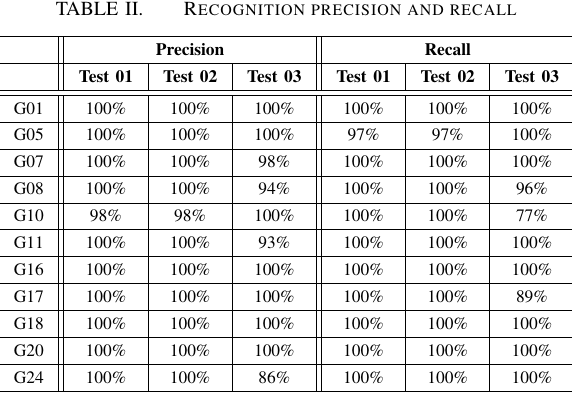
2) Discussion: Results show a good recognition rate. In fact, all gestures were recognized during stroke, without